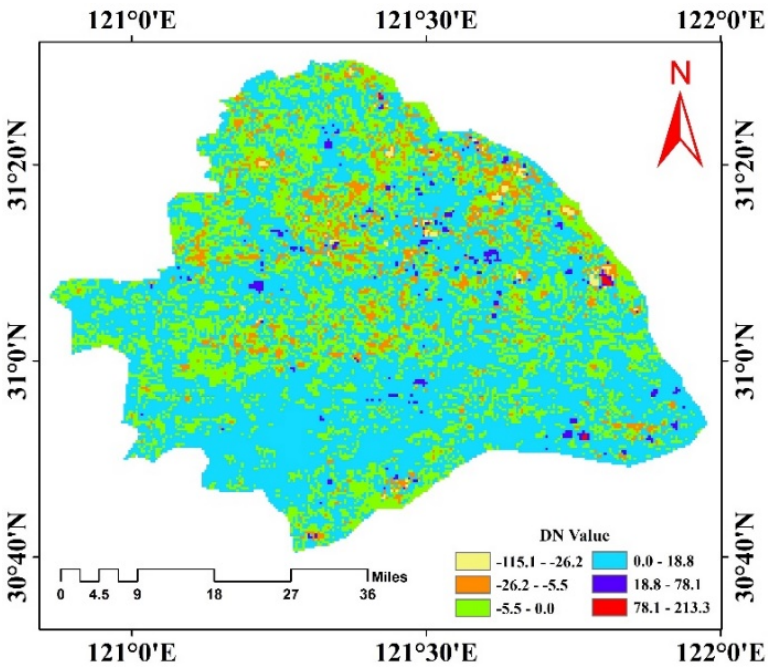
Figure 18. Difference chart of night light data of Shanghai main urban area in 2020 and 2018.